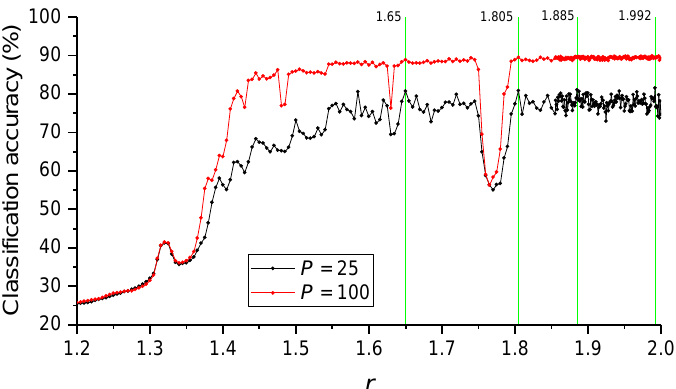
Figure 5. The dependence of the classification accuracy on the parameter r at P = 25 (LogNNet-784:25:10) and P = 100 (LogNNet-784:100:10).